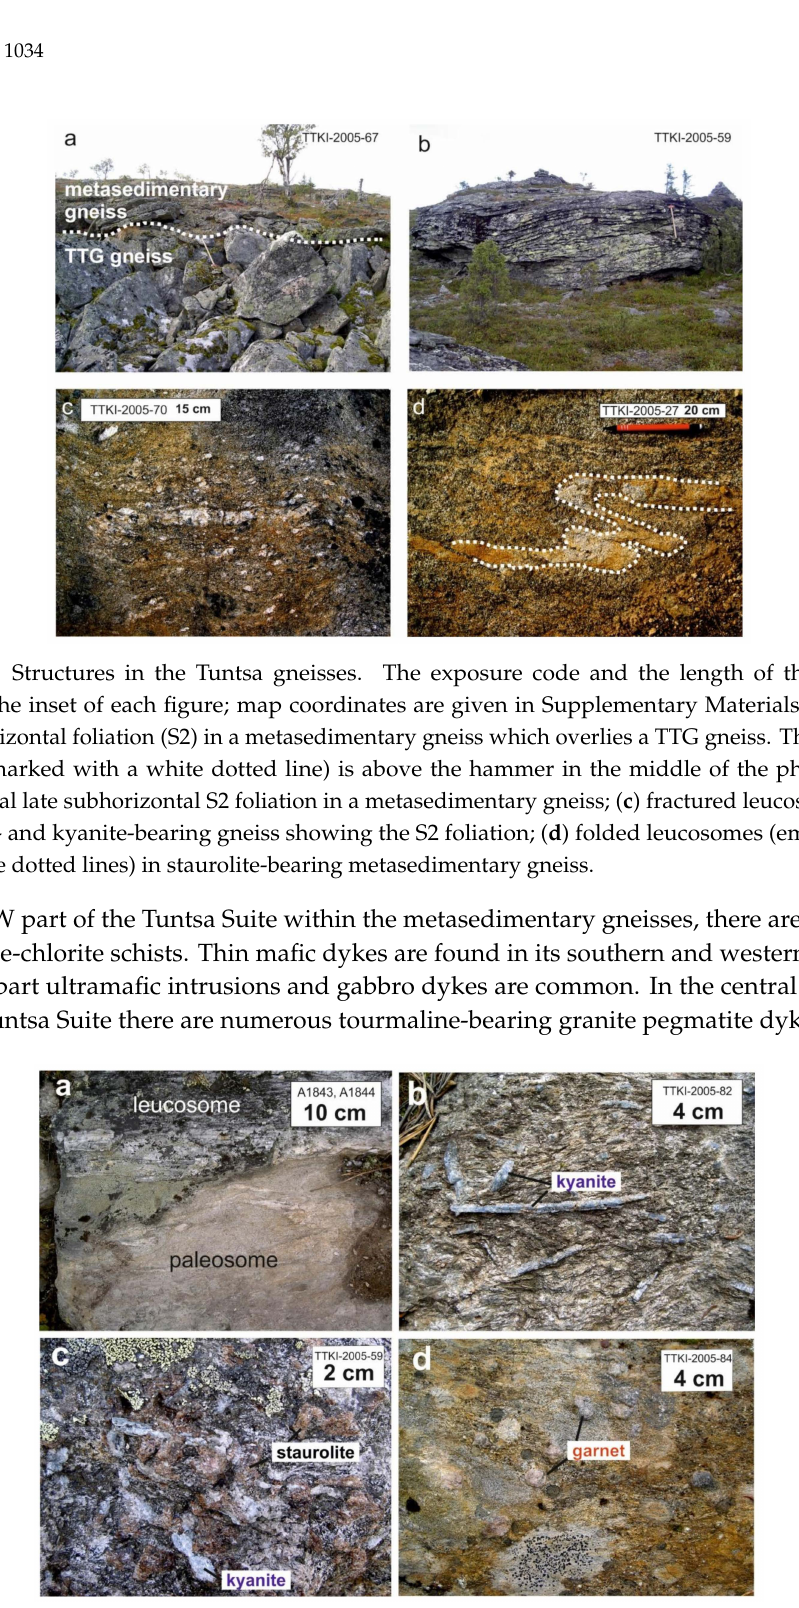
Figure 4. Photographs of the Tuntsa metasedimentary gneisses and porphyroblasts. ( a ) deformed paleosome and leucosome (nomenclature after Sawyer [60]) in the exposure TTKI-2005-32, sampled for age determinations; ( b ) kyanite crystals in cordierite-bearing gneiss; ( c ) staurolite and kyanite grains